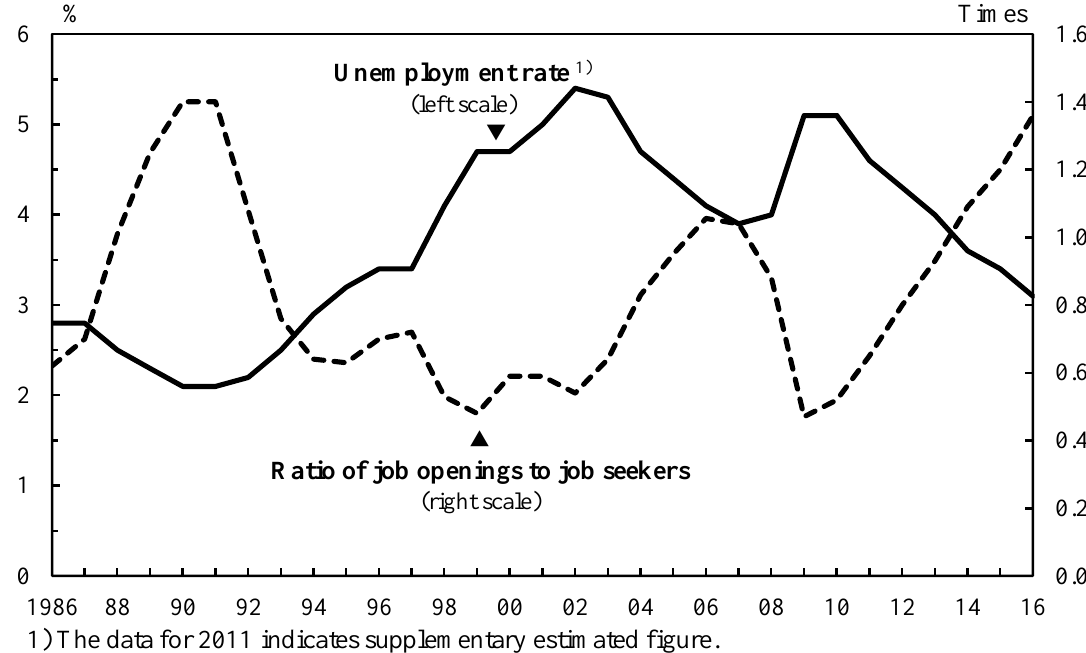
1) The data for 2011 indicates supplementary estimated